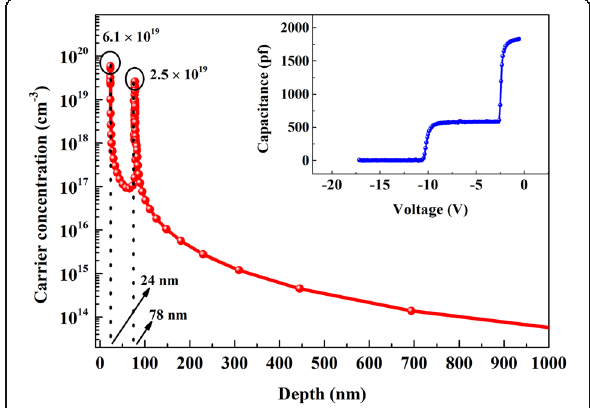
Fig. 4 C-V characteristics and electron distribution curve of AlGaN double channel heterostructure